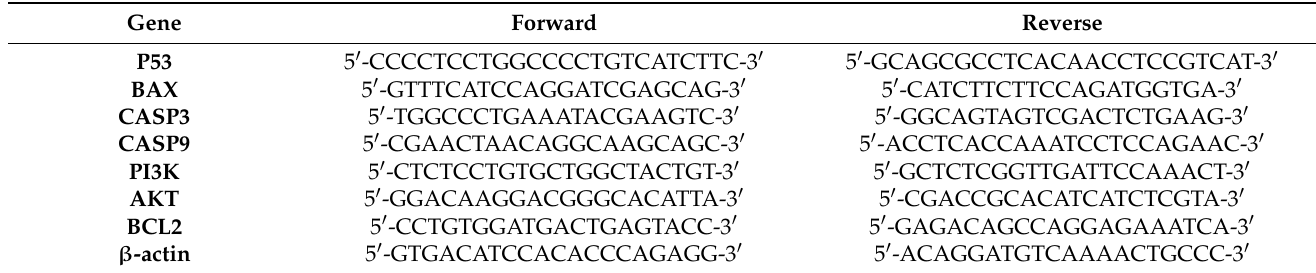
Table 3. Forward and reverse primers used in gene expression